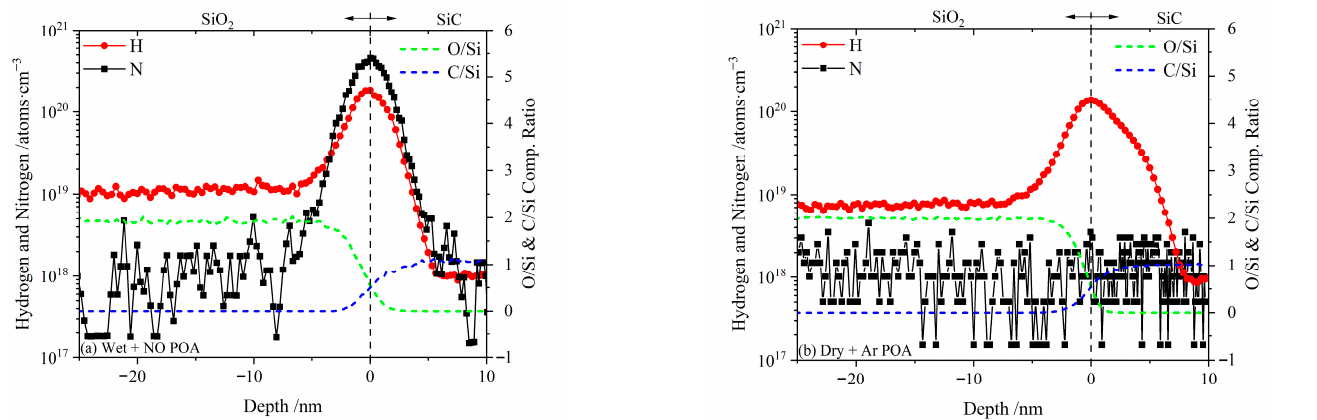
Figure 1. SIMS profiles for the ( a ) H&N hybrid and ( b ) Ar passivation samples.